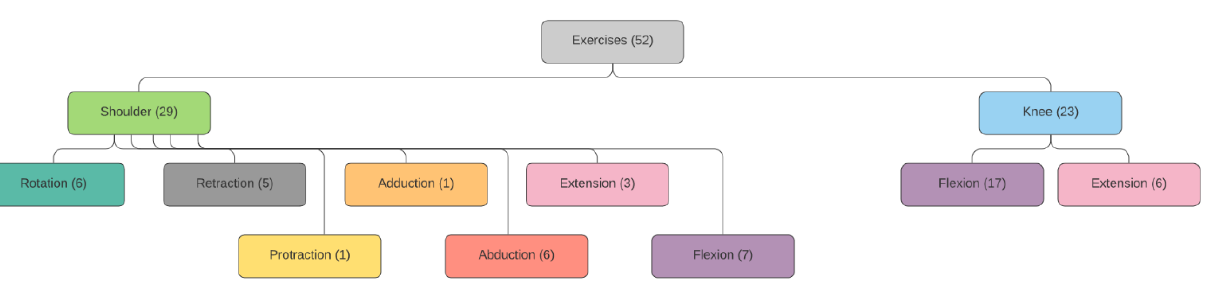
Figure 14. Set of implemented exercises.